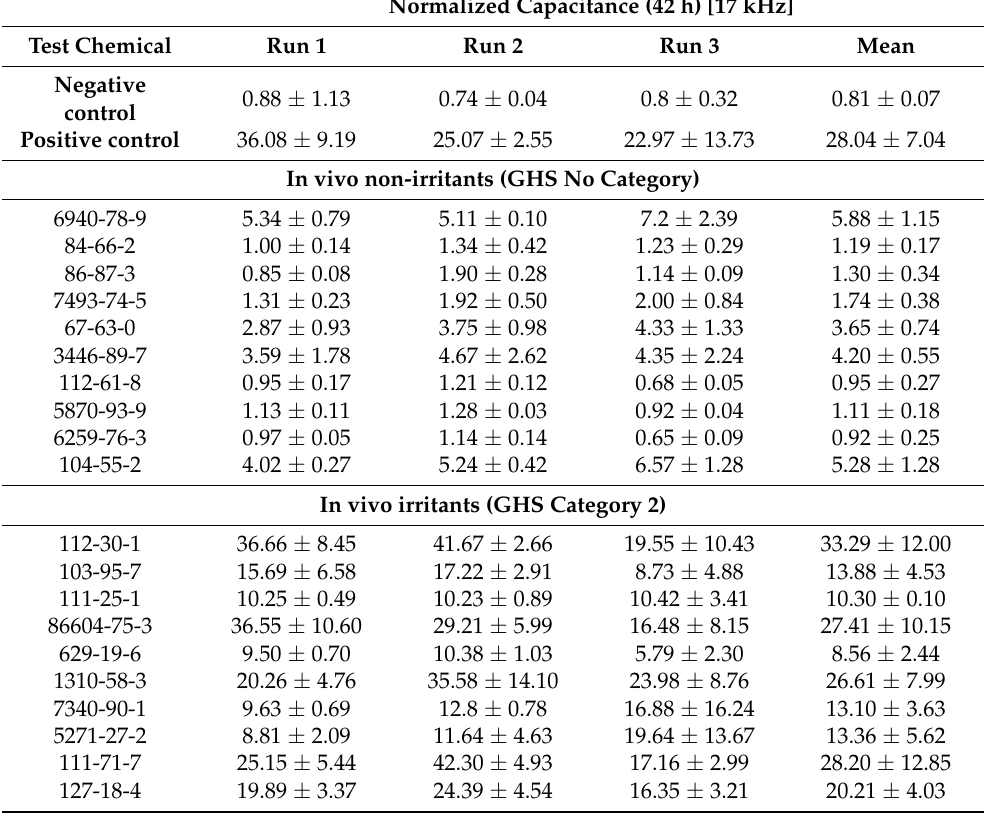
Table 4. Within-laboratory reproducibility of the QileX-RhE normalized capacitance. Data are presented as mean ±